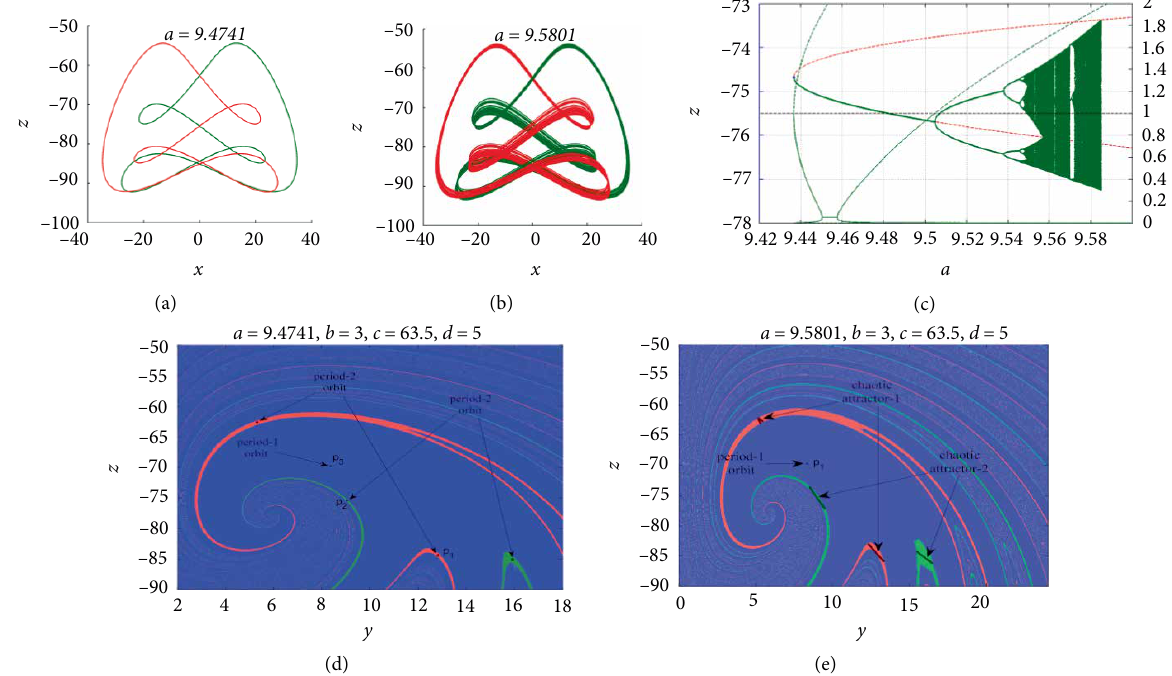
Figure 6: The period-2 limit cycle, its bifurcations and basin of